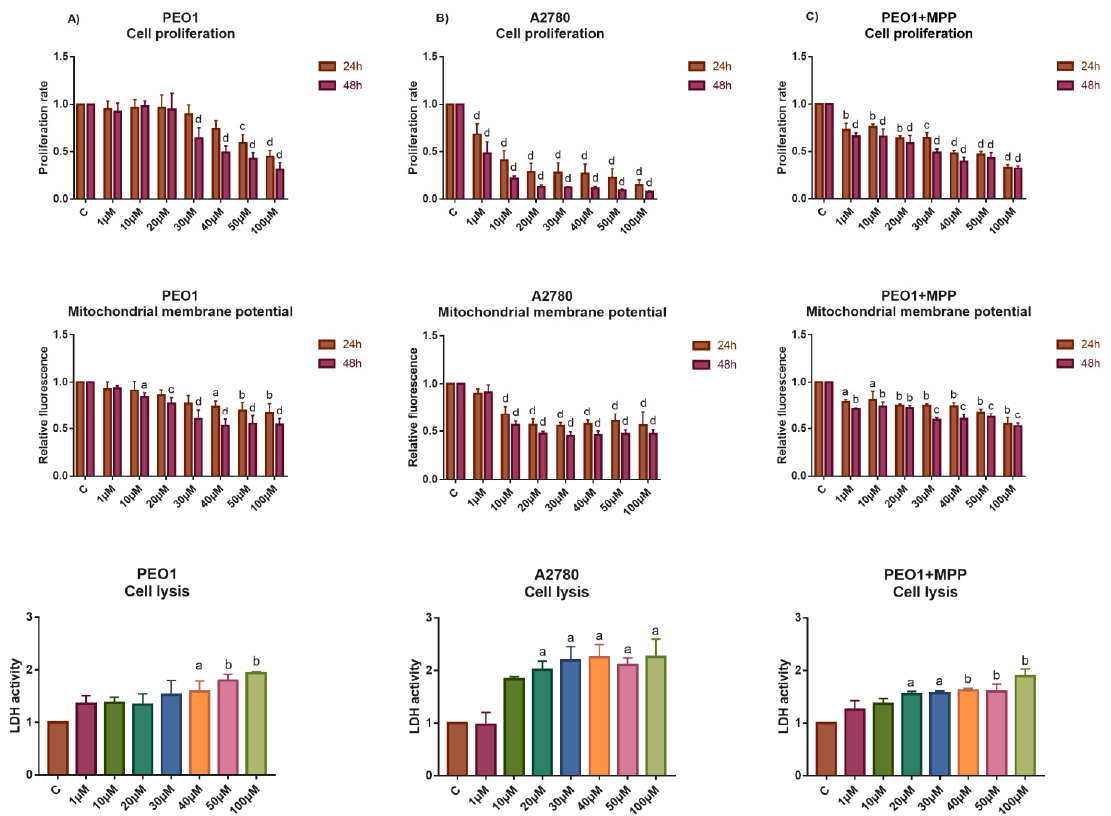
Figure 2. Study the effect of high-dose E2 exposure to the cell proliferation, apoptosis and cell lysis of the PEO1 and A2780 cell cultures. Phenotypic characterization of high-dose E2 treatment was made in the PEO1 ( A ) and A2780 ( B ) cell lines as well as in the PEO1 cell line in the presence of 10 nM MPP ( C ). The rate of cell proliferation, mitochondrial membrane potential (24 h and 48 h after the treatment), and LDH activities (48 h after the treatment) were determined relative to the non-treated control (1). The data are presented as the mean ± S.D. a: p < 0.05; b: p < 0.01; c: p < 0.001; d: p < 0.0001.